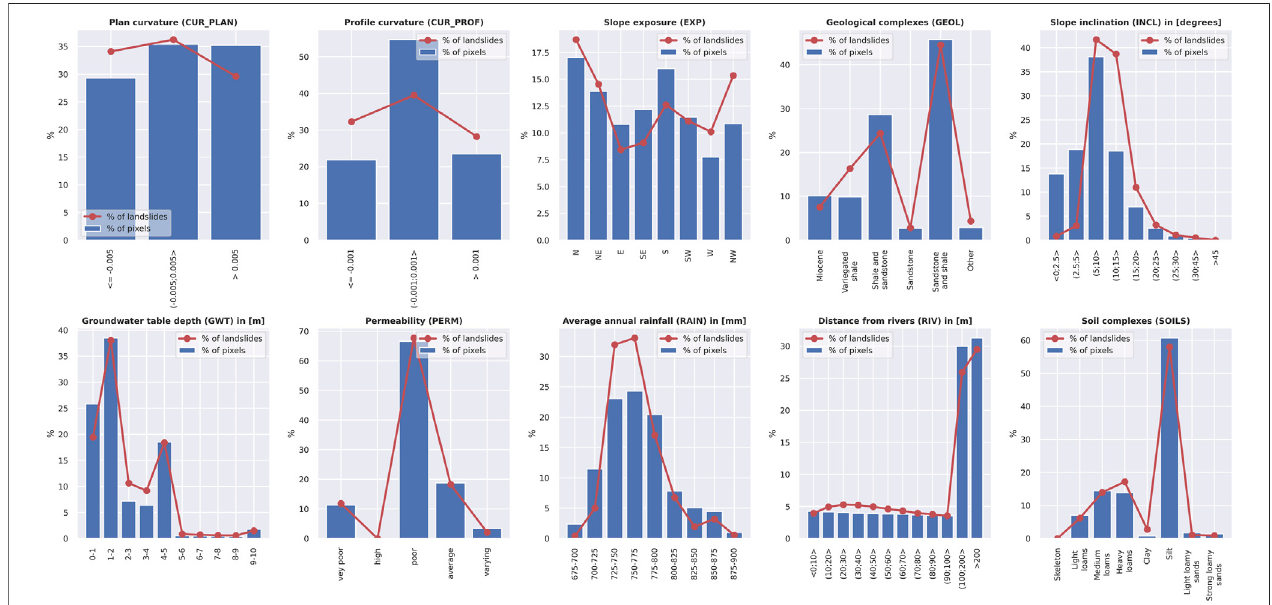
FIGURE 3 | Distribution of environmental factors within analyzed area and relationship between landslides and the analyzed